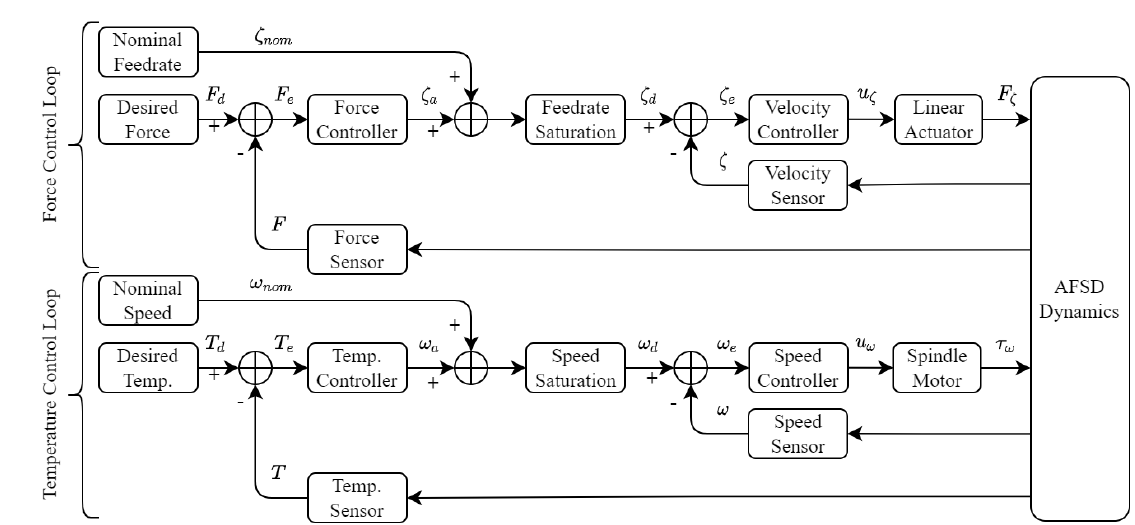
Figure 6. The combined control structure depicting the developed outer loop temperature and force controllers. Inputs include the nominal feedrate of the linear actuator, the nominal spindle speed, the desired temperature of the deposition, and the desired force applied to the feedstock. Temperature feedback is enabled using the developed thermocouple collar and the custom tool. Force feedback is enabled using the measured current from the linear